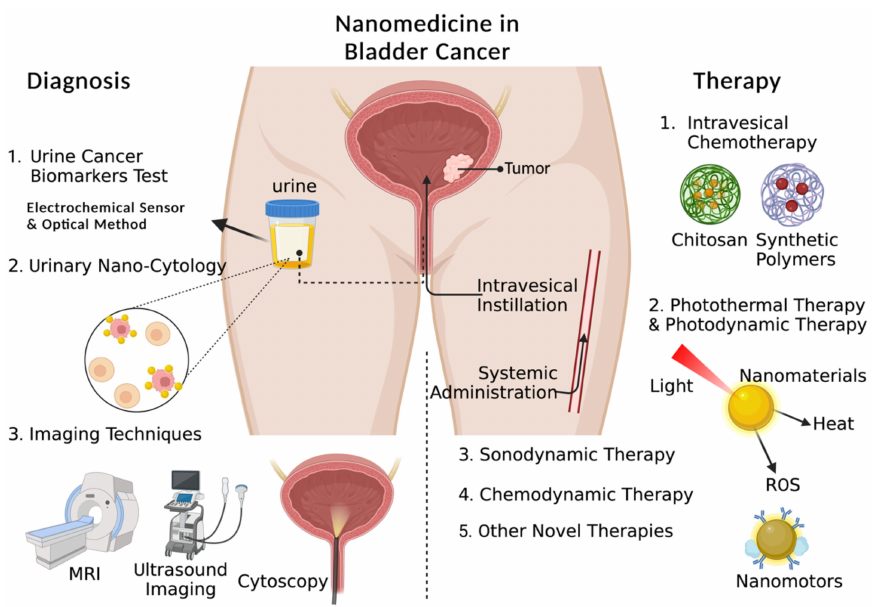
Figure 1. Schematic illustration of nanomedicine in bladder cancer diagnosis and therapy (Created with BioRender.com, access date: 10 December